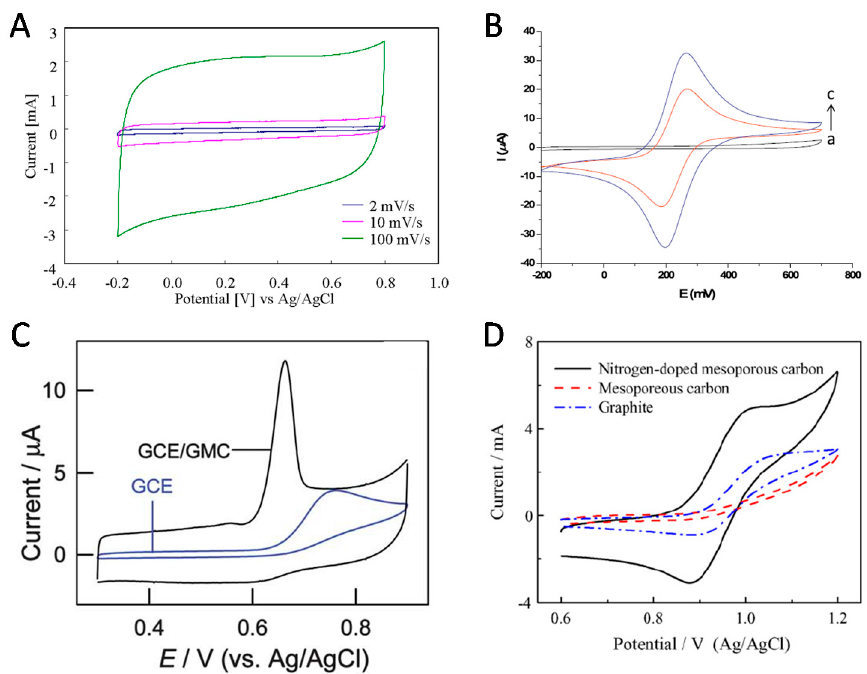
Figure 4. ( A ) Cyclic voltammograms of an OMC (COU-3 type) film electrode at various scan rates (reproduced from [42]). ( B ) Cyclic voltammograms of 1 mM [Fe(CN) 6 ] 3 − /[Fe(CN) 6 ] 4 − in 0.1 M KCl recorded at 75 mV ∙ s − 1 using screen-printed carbon electrodes (SPCE): (a–c) blank, bare SPCE, and CMK-3/chitosan modified SPCE (reproduced from [43]). ( C ) Cyclic voltammograms of xanthine recorded at bare glassy carbon electrode (GCE) and graphitized mesoporous carbon (GMC) modified GCE (reproduced from [44]). ( D ) Cyclic voltammograms on different carbon electrodes recorded in 3 M H 2 SO 4 and 1 M VOSO 4 at 50 mV ∙ s − 1 (reproduced from [48]).